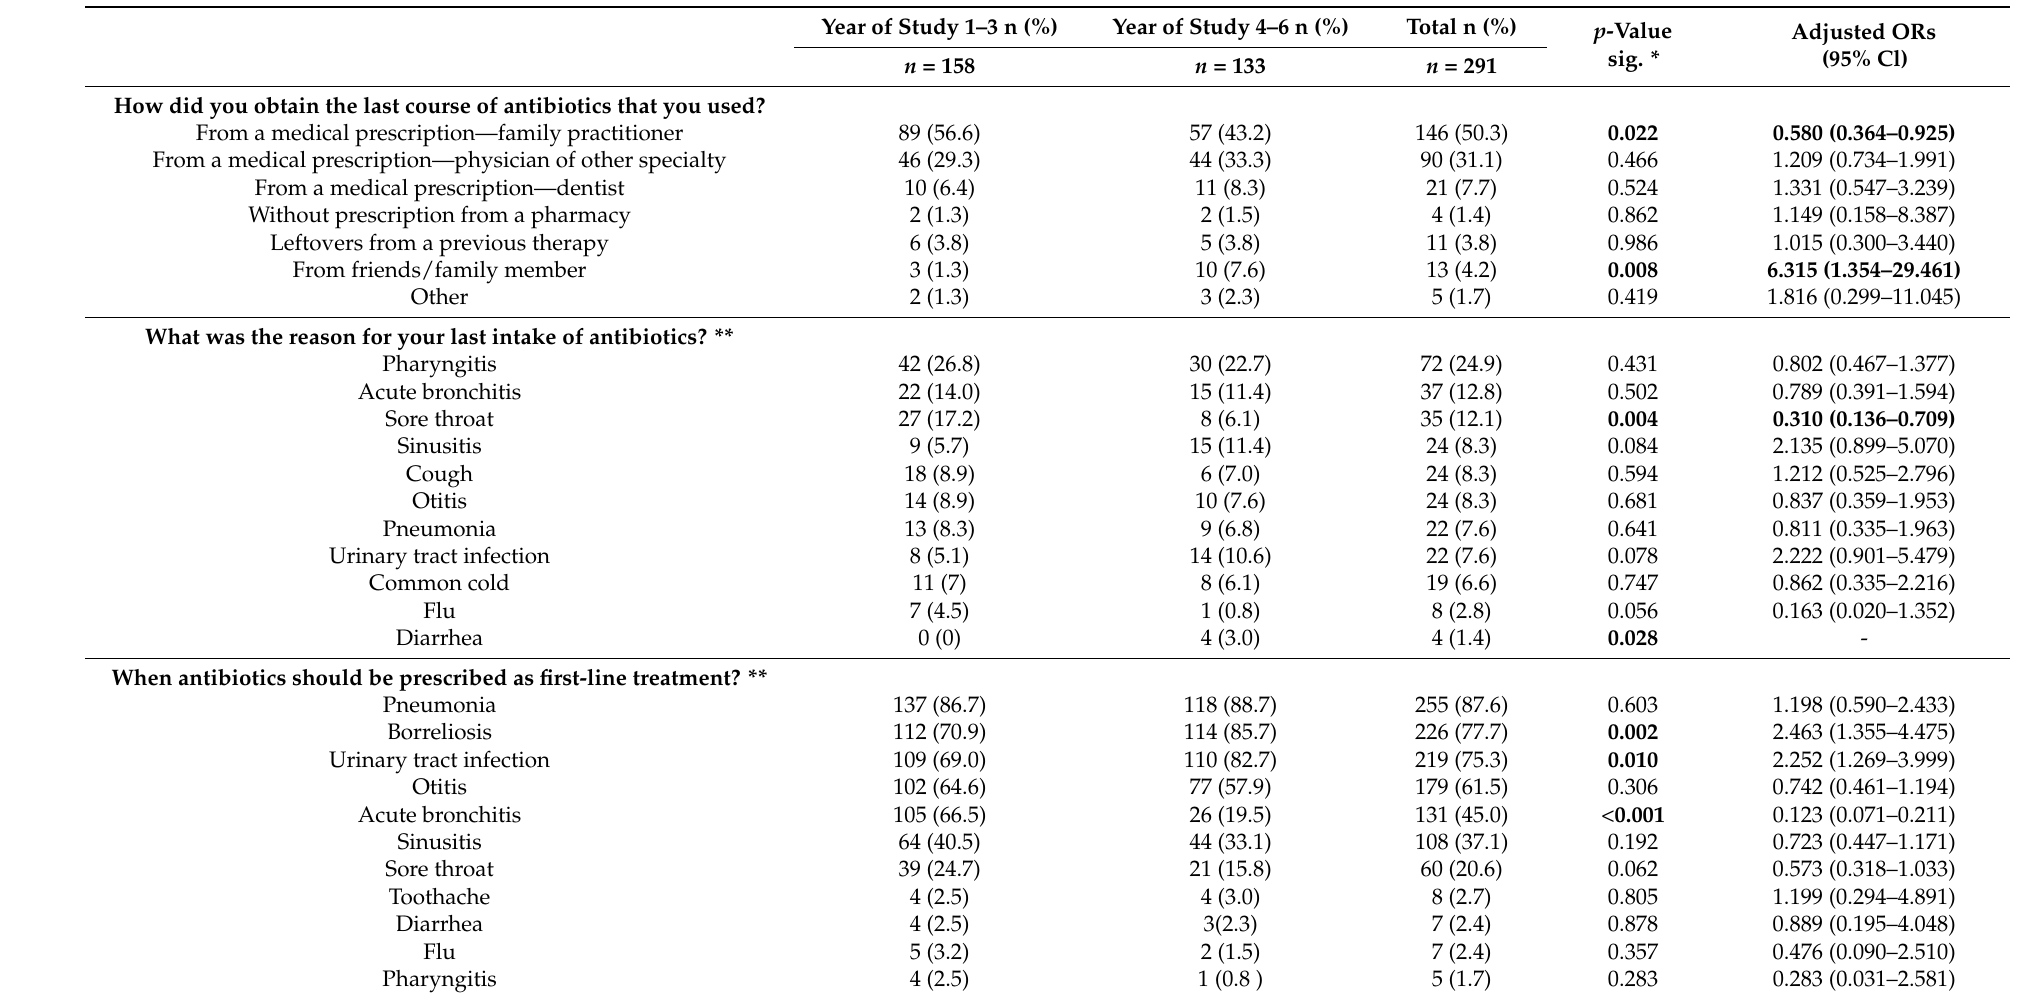
Table 1. Knowledge and attitude towards antibiotic